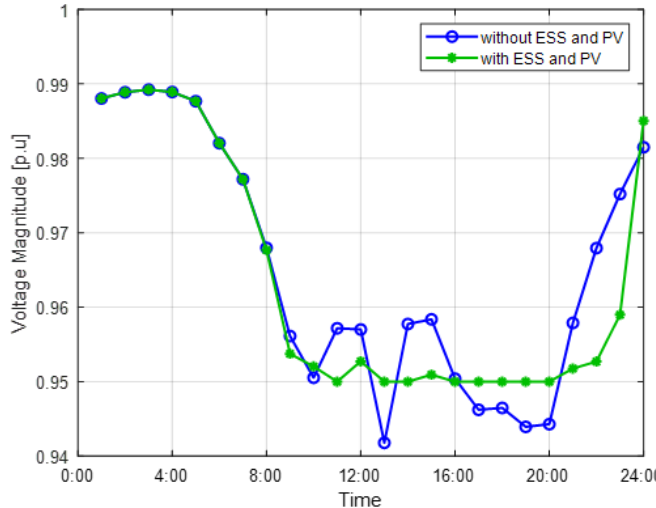
Figure 15. Voltage profiles of node 18 on a summer ’s day.